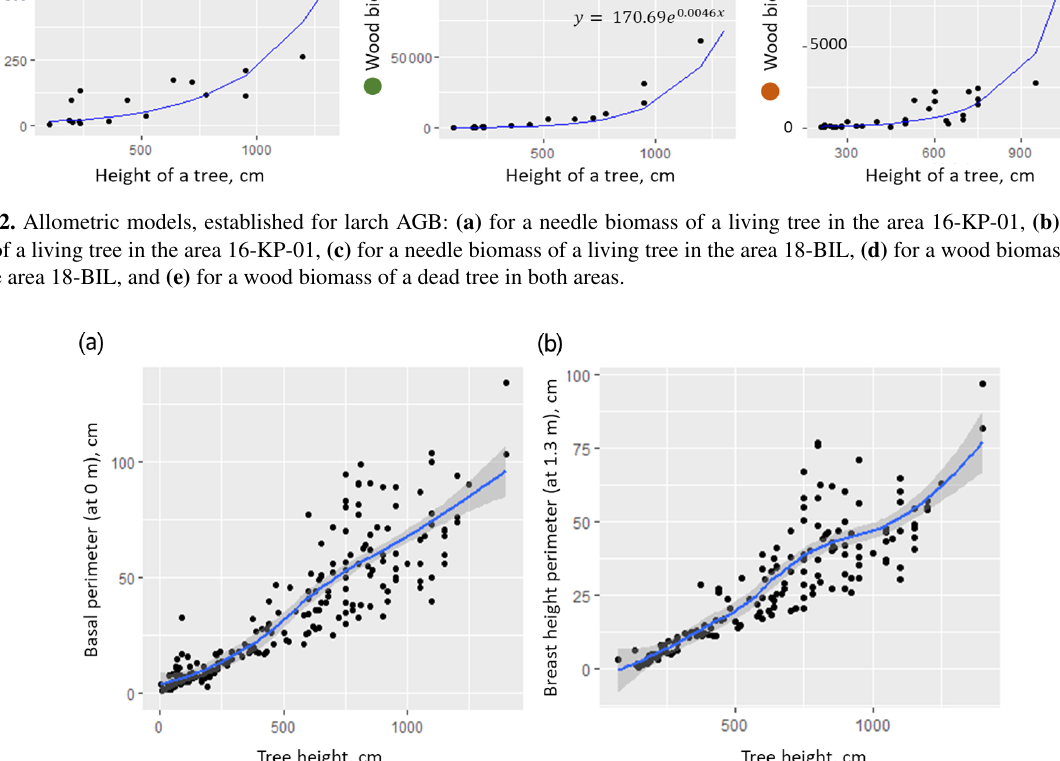
branches, needles from small branches, stem (ideally three tree discs at 0, 1.3, and 2.6 m heights), and cones. Total AGB of an individual tree (g) from the field survey of 2018 expe- dition was calculated as